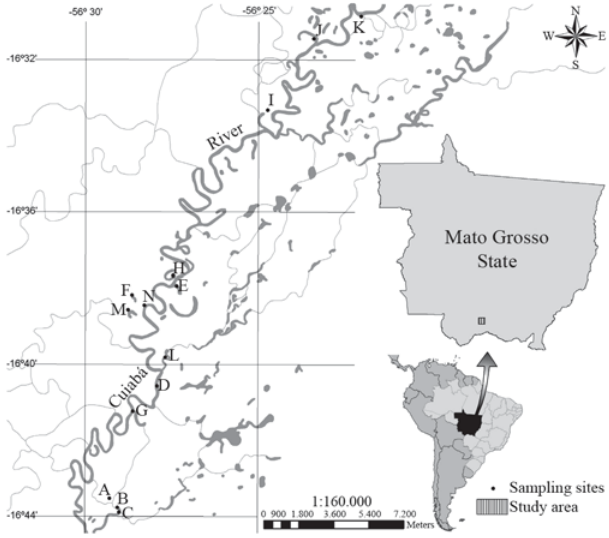
Fig. 1. Location of sampling sites in the floodplain of Cuiabá River, Pantanal, Mato Grosso State,